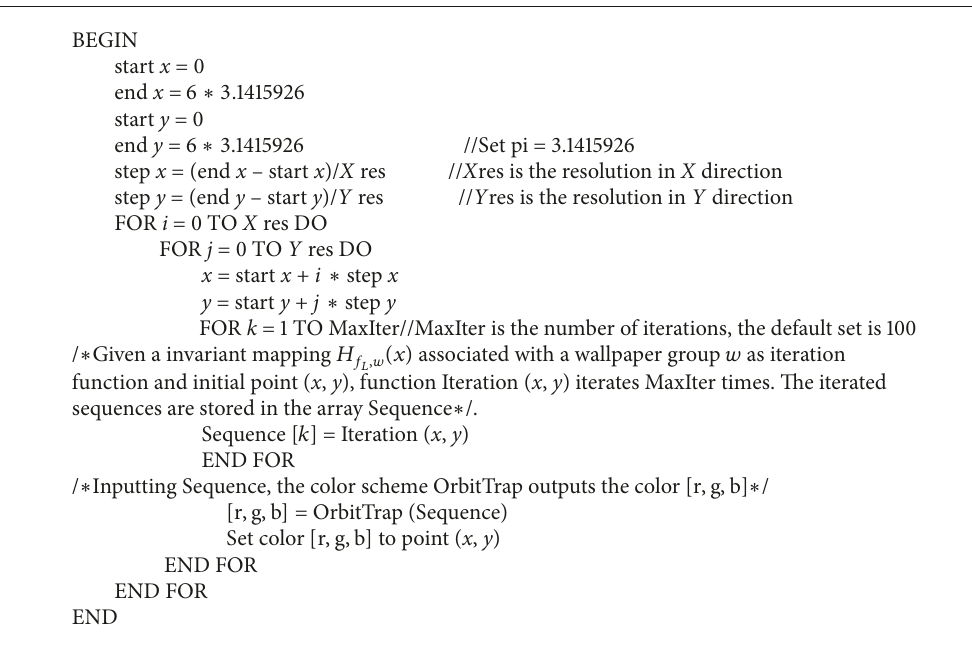
Algorithm 1: CreatingWallpaperPattern()// algorithm for creating patterns with the wallpaper symmetry.